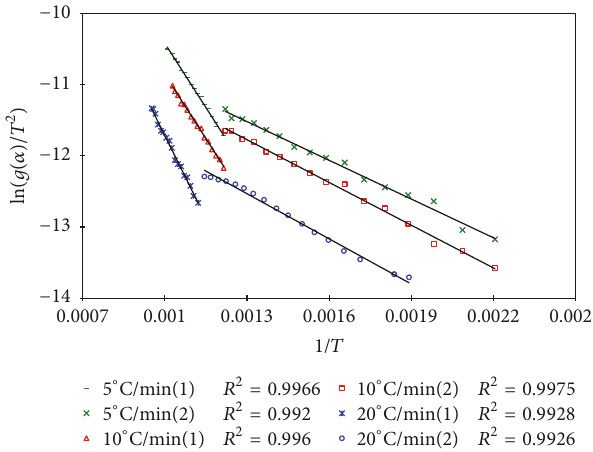
Figure 3: Kinetic fitting lines of organics degradation stages at different heating